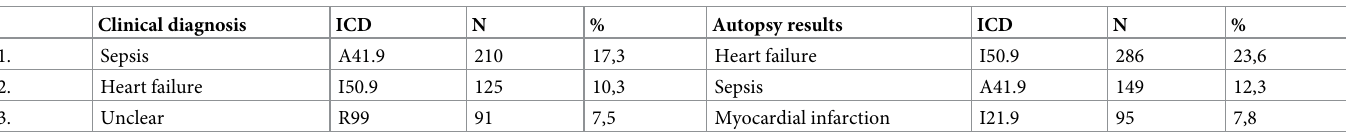
Table 5. Most common clinical vs. most common autopsy